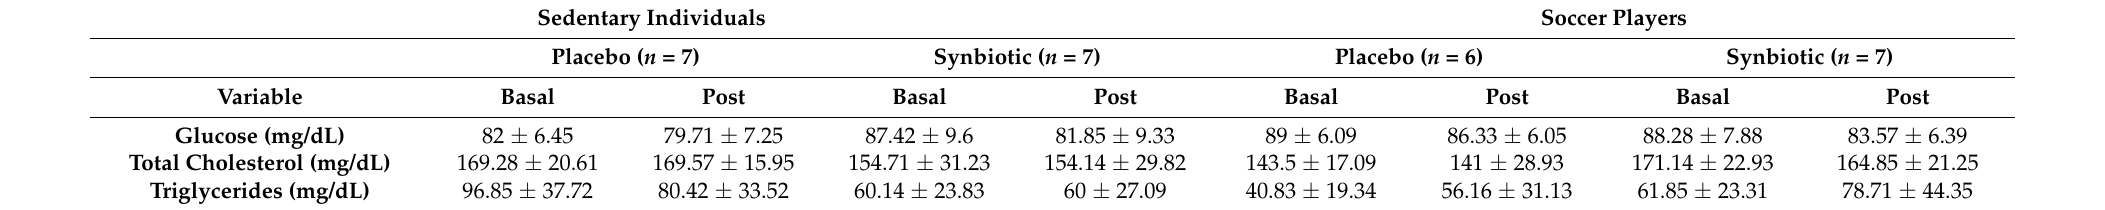
Table 4. Metabolic profile